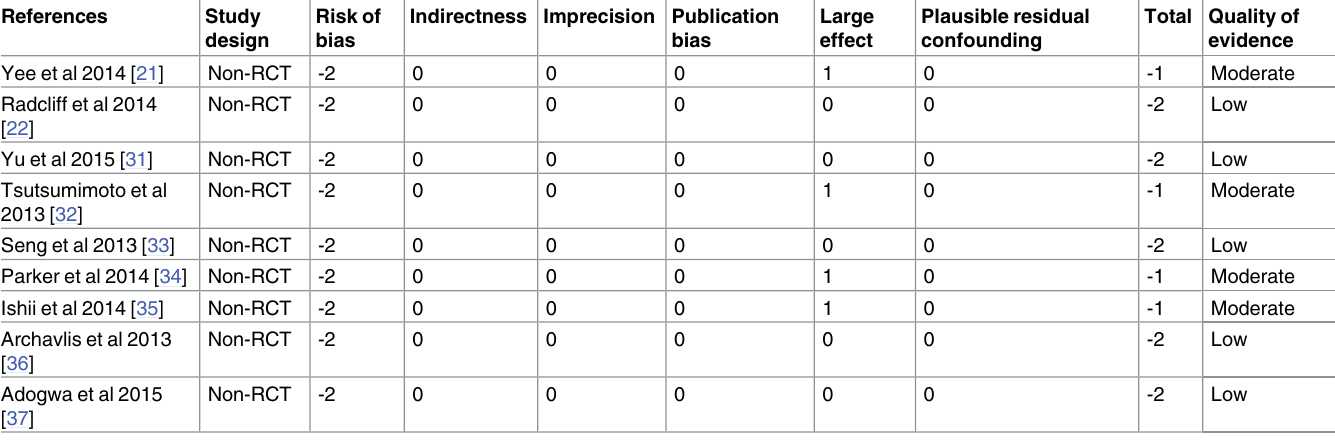
Table 4. Grading of clinical studies following GRADE